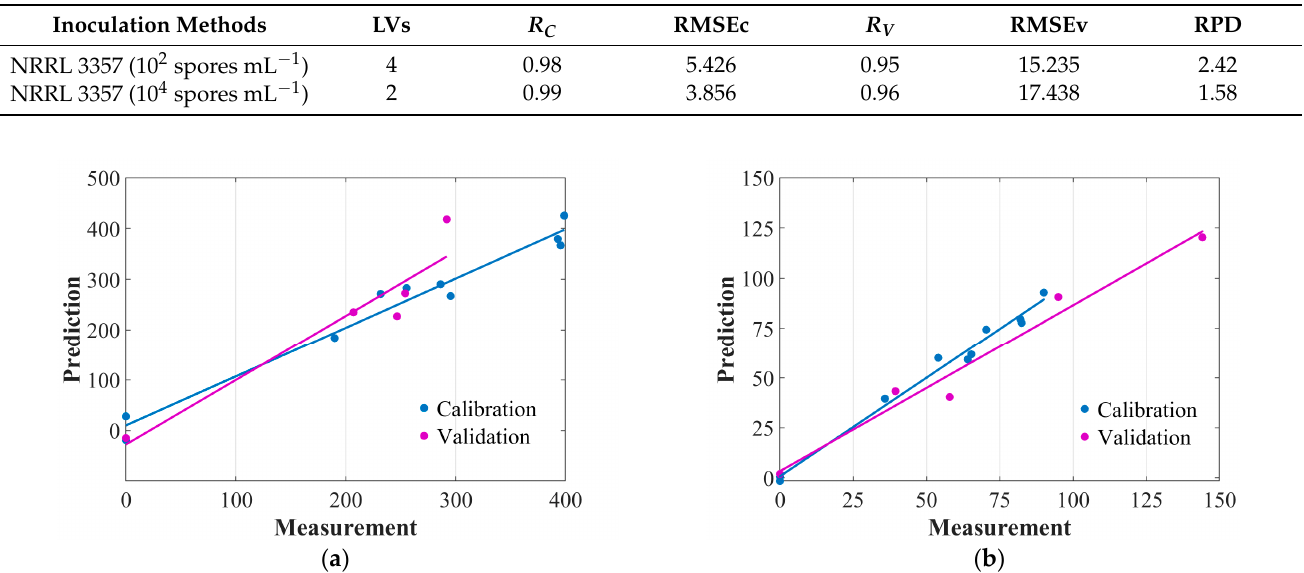
Figure 6. Prediction results of multispectral models. MAM inoculated ( a ) NRRL 3357 with concen- tration of 10 2 spores mL − 1 ; ( b ) NRRL 3357 with concentration of 10 4 spores mL − 1 .